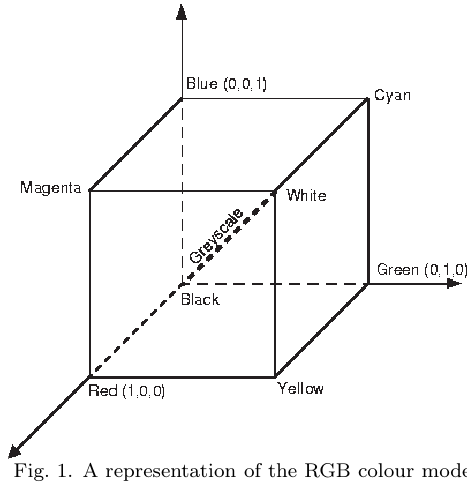
Fig. 1. A representation of the RGB colour model expressed in Cartesian